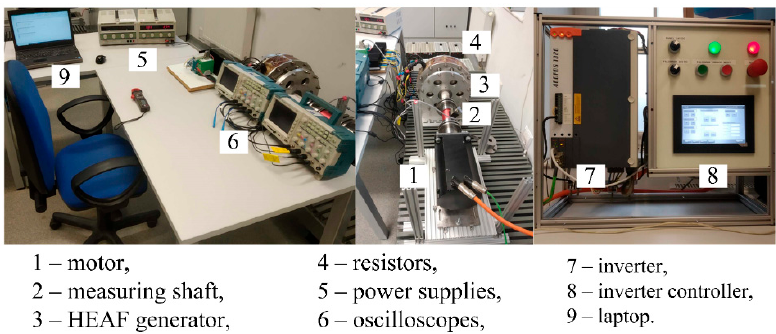
Figure 9. The prototype of the HEAFM machine: ( a ) A stator with a rotor, ( b ) A complex machine with a caliper 20 cm long [55].